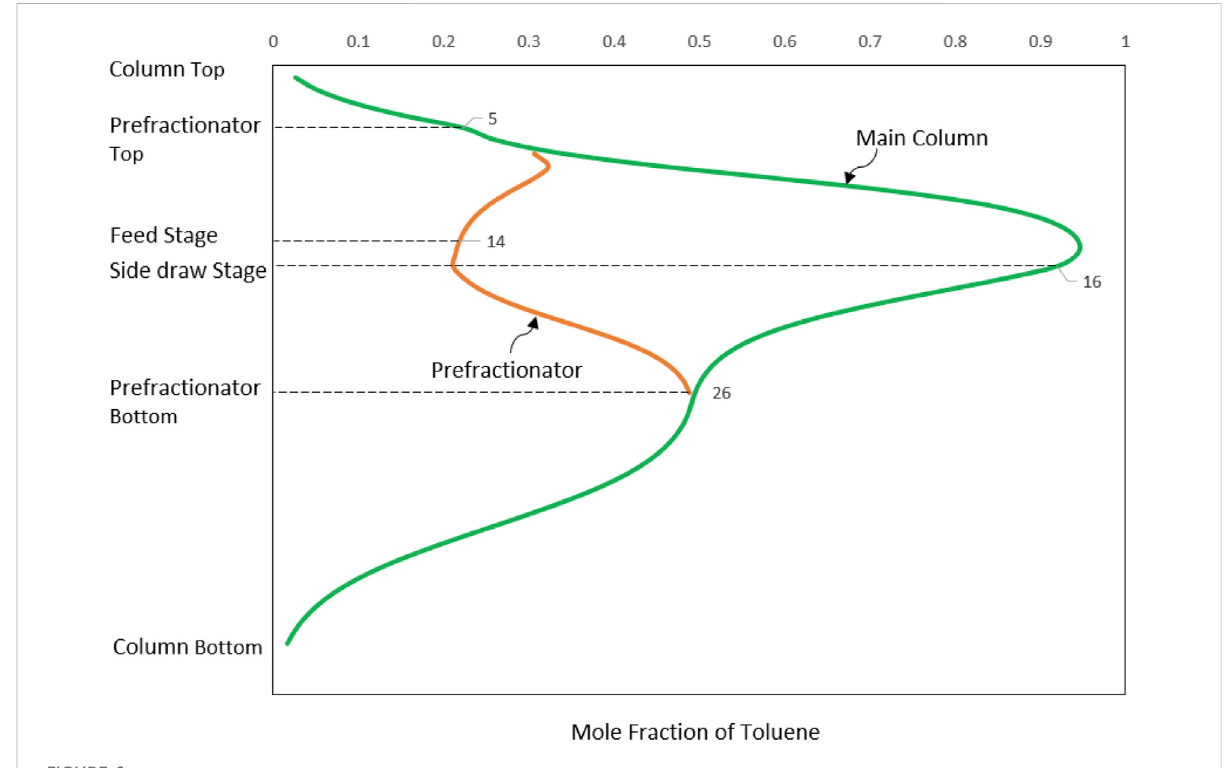
FIGURE 6 Composition pro fi les of Toluene in the DWC for Example 1.